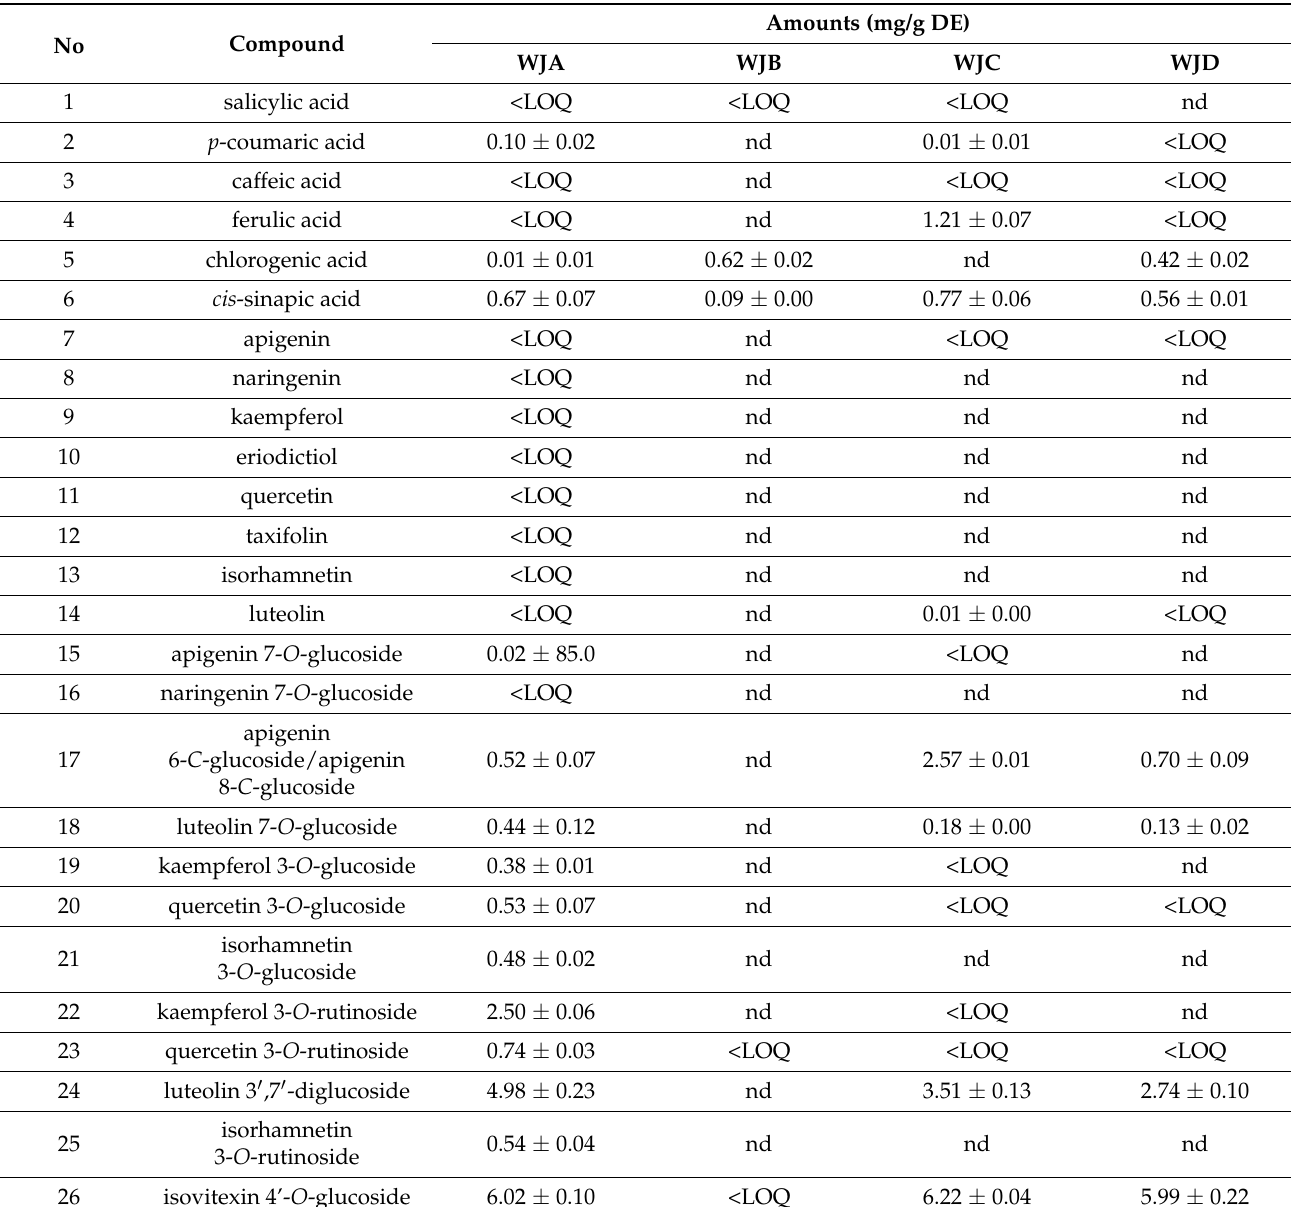
Table 2. Content of phenolic acids and flavonoids in the leaves, roots, and flowers of E. japonicum . nd—not detected; LOQ—limit of quantification; DE—dry